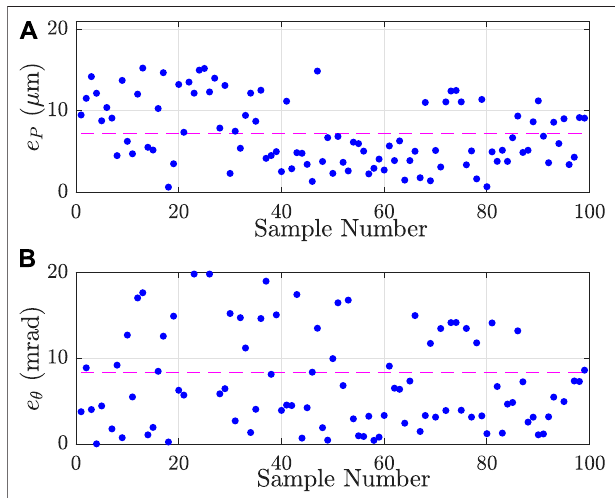
FIGURE 8 | Positioning (A) and orientation (B) errors of the model (respectively e P and e θ ) for the different samples of the calibration set of joints coordinates. The dashed-lines are the mean values of positioning and orientationerrorsandrespectivelycorrespondto7.19µmand1.7 mrad.